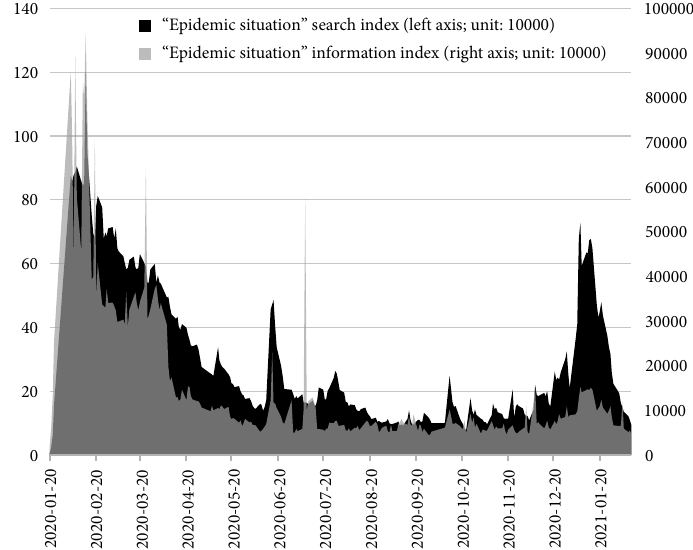
Figure 1. “Epidemic Situation” search index and information